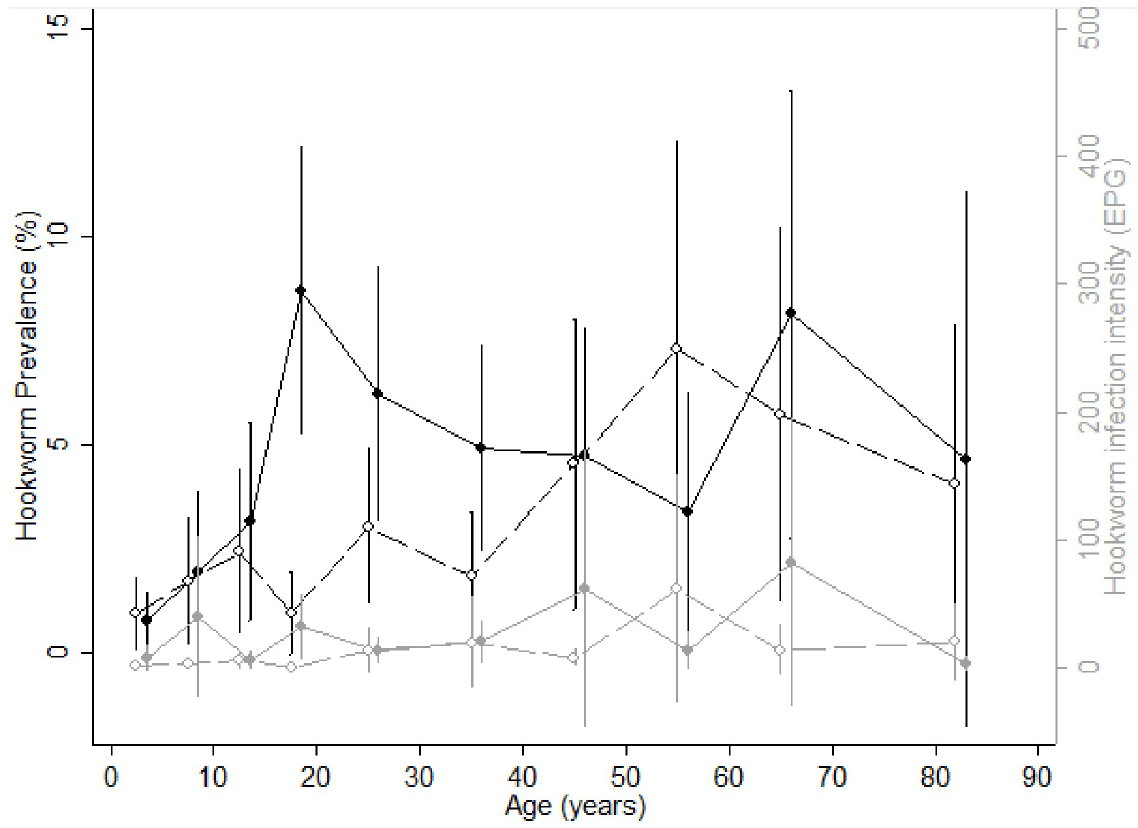
Fig 4. Age-infection profiles for hookworm. (A) Prevalence (black lines) and intensity (grey lines) of hookworm infection by age for males (solid line and circles) and females (dashed lines and empty circles). Vertical bars represent confidence